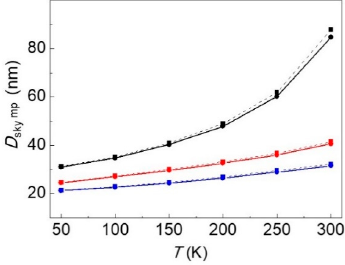
Figure 3. 2D (solid lines) and 3D (dashed lines) most probable skyrmion diameters as a function of T for μ 0 H ext = 0 mT (black lines); μ 0 H ext = 25 mT (red lines) and μ 0 H ext = 50 mT (blue lines). < > vs. T for the 3D sky D